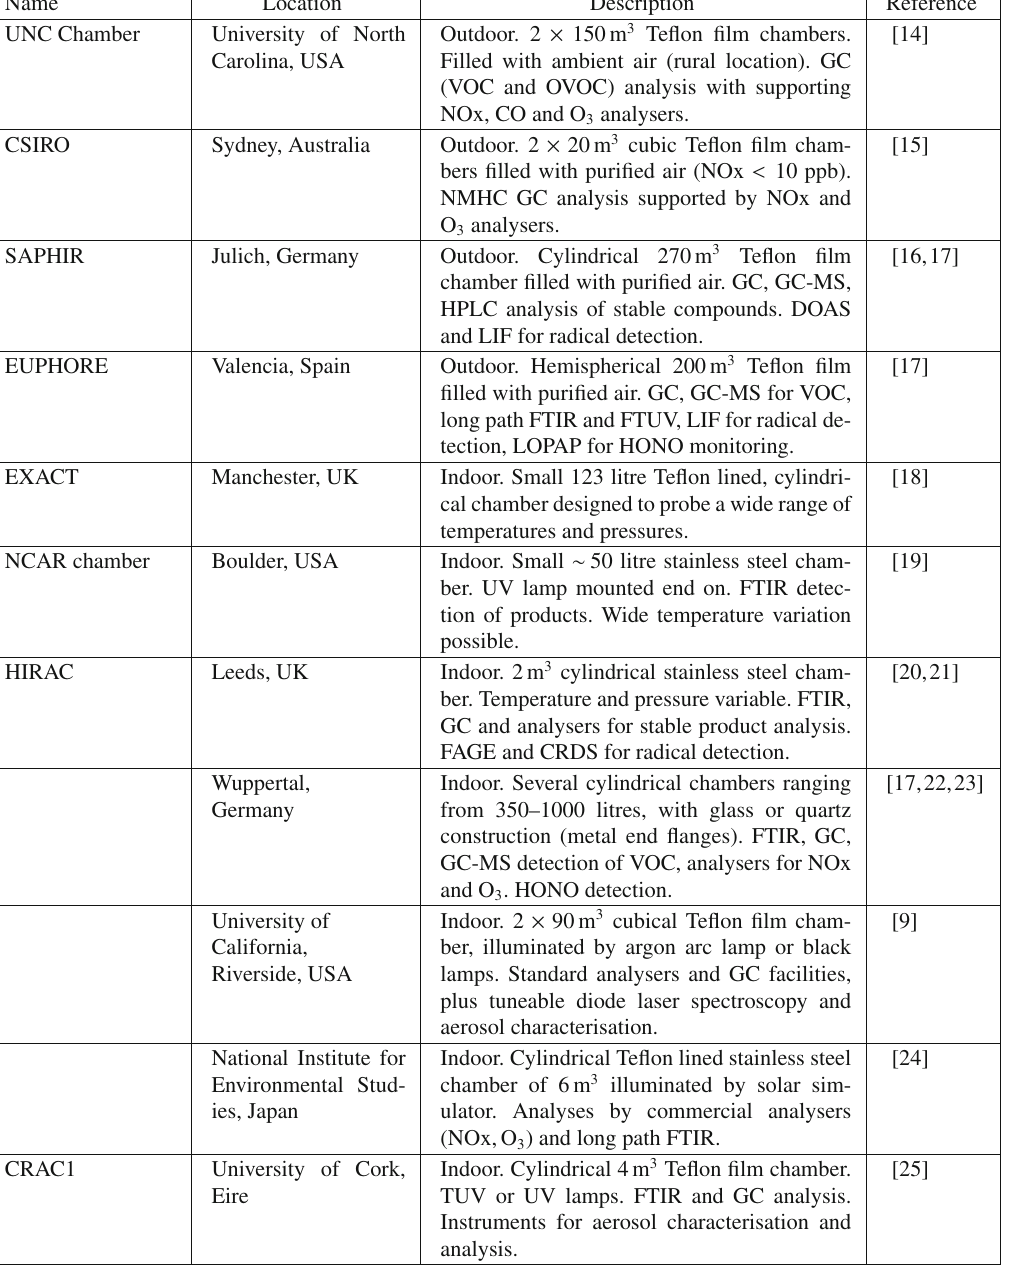
Table 1. Examples of environmental chambers which focus predominantly on gas phase